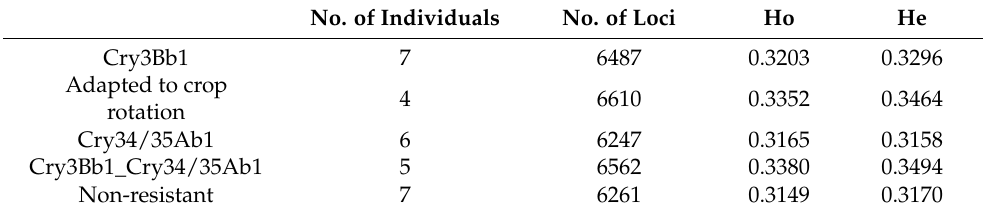
Table 2. Expected heterozygosity (He) and observed heterozygosity (Ho) values for western corn rootworm populations over all loci.